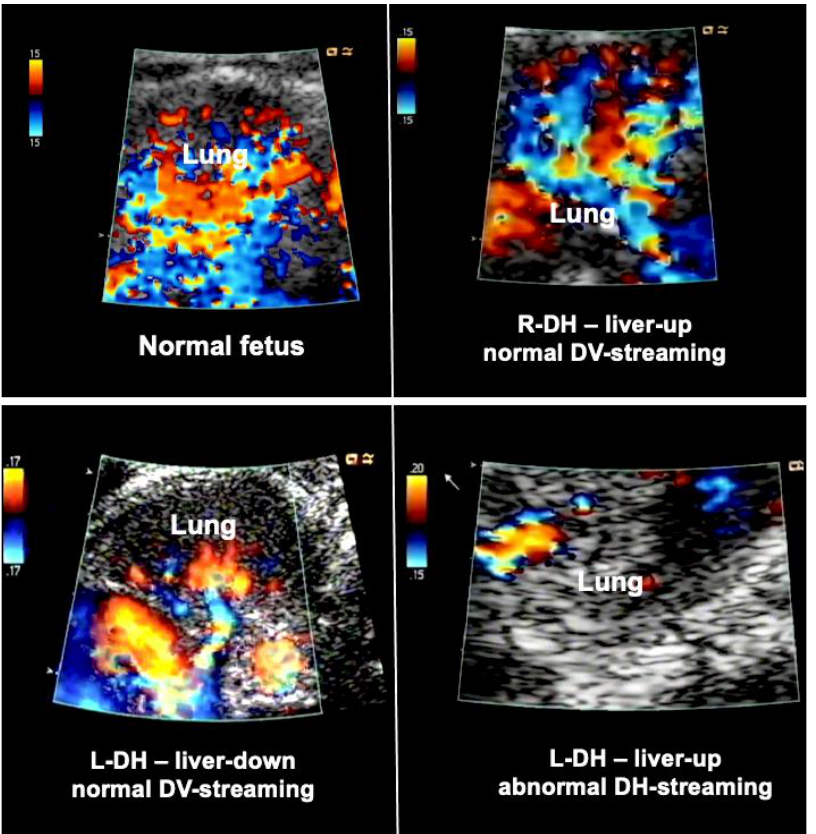
Figure 3. Examples of lung blood flows of a normal fetus ( top left ) and fetuses with diaphragmatic hernia during diagnostic materno – fetal hyperoxygenation. Most fetuses with liver-down left diaphragmatic hernia (L-DH) exhibit normal streaming of ductus venosus blood into the left side of the heart ( bottom left ). As a result, both sides of the heart are of equal size, pulmonary blood flow signals are easily visualized, and pulmonary vasodilation in response to diagnostic maternal hyperoxygenation can be produced. In contrast, most fetuses with liver-up L-DH exhibit preferential streaming of ductus venosus blood into the right side of the heart of the fetus. As a result, there is less preload to the left side of the heart, which in turn becomes hypoplastic. In addition, pulmonary blood flow is often markedly decreased ( bottom right ). Fetuses with right diaphragmatic hernia (R-DH), despite liver herniation, present with normal ductus venosus streaming into the heart. Therefore, as a rule, in these fetuses, neither isolated left, nor isolated right heart hypoplasia are observed, and color Doppler signals of pulmonary blood flow are often normal ( top right ).